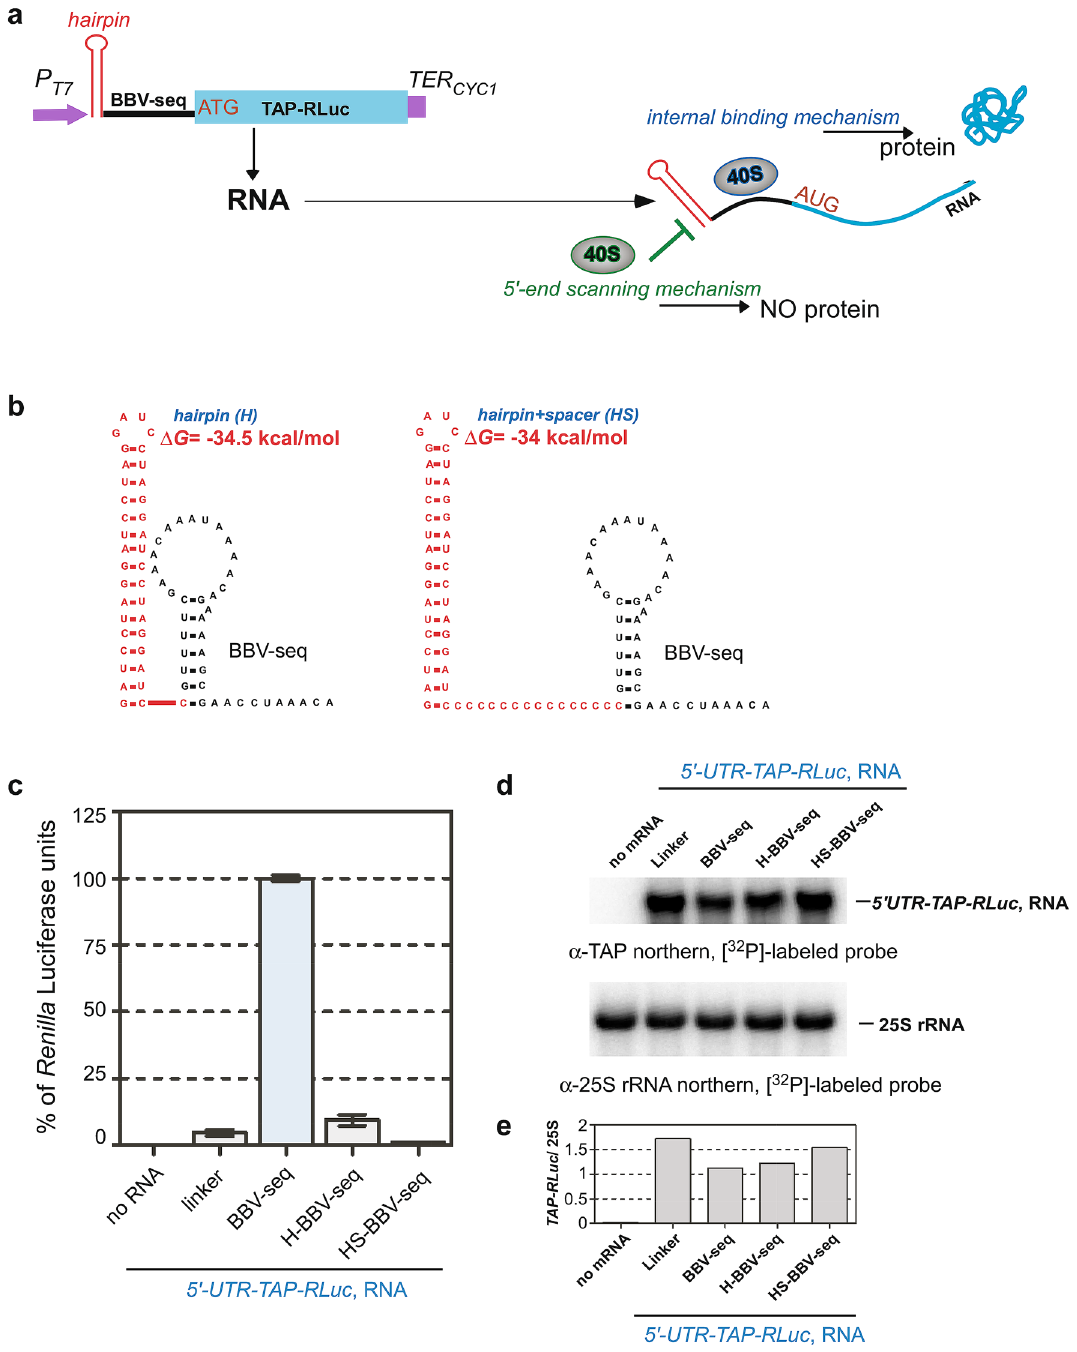
Figure 4. BBV-seq-driven translation initiation occurs via a scanning mechanism in cell-free translation reactions. ( a ) Schematic representation of the strategy used to distinguish between two alternative translation initiation mechanisms: 5 ʹ -end scanning vs. internal binding of the 40S subunit (as a part of 43S PIC). Left panel depicts insertion of an RNA loop (marked in red) upstream of the BBV-seq sequence in the pYes-based construct described in Fig. 1a-1. The right panel illustrates that protein synthesis would be blocked by the hairpin at the 5 ′ end of mRNA when only the scanning mechanism can be used, and that protein synthesis would proceed if translation is initiated internally regardless of the presence of hairpin. ( b ) Secondary structures of the hairpin fused to BBV-seq directly (left) or via an unstructured poly-C spacer (right). ( c ) mRNAs as indicated were translated in vitro using yeast lysates as described in Fig. 1d. Production of the TAP-RLuc reporter was analyzed using a Renilla luciferase assay. Data are represented as % Renilla Luciferase units derived from the reaction containing BBV-seq-WT-TAP-RLuc mRNA. Error bars represent standard error of the mean (SEM) of three individual experiments. ( d ) RNA was extracted from the luciferase reactions and analyzed by northern hybridizations with the indicated probes. ( e ) The TAP-RLuc /25S rRNA ratios of hybridization signals in each lane of the blot shown in ( d